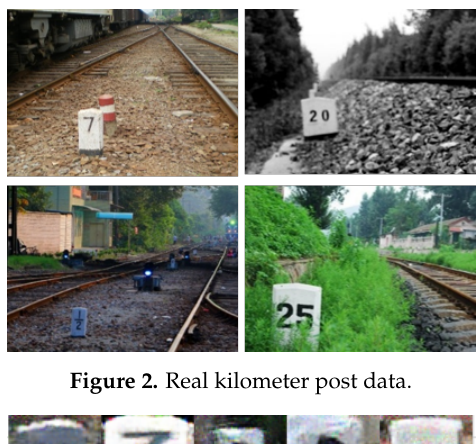
Figure 2. Real kilometer post data.